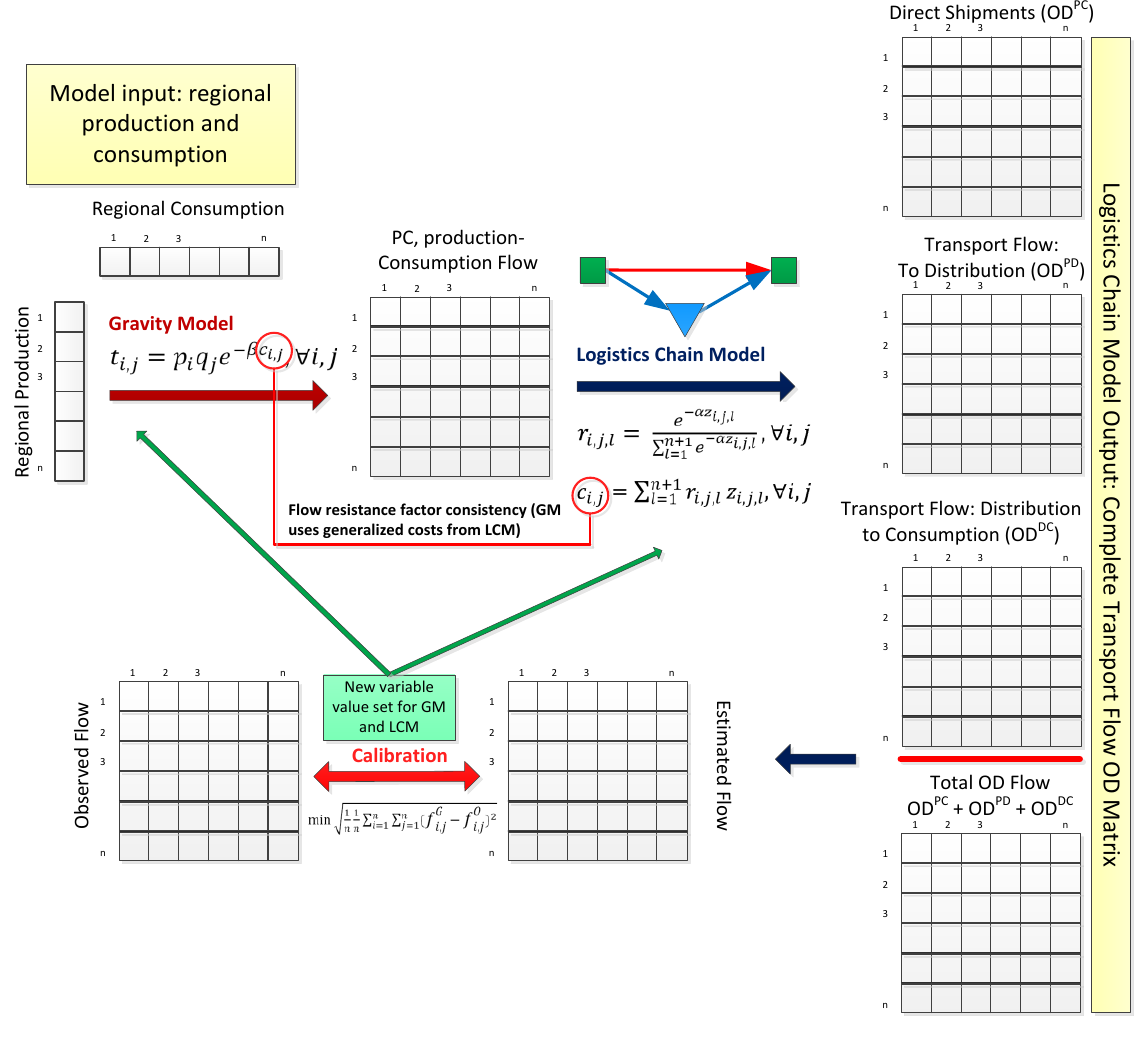
Figure 1. Conceptual representation of gravity and logistics chain combined model The next subsections describe the mathematical specification of the trade model, the logistic